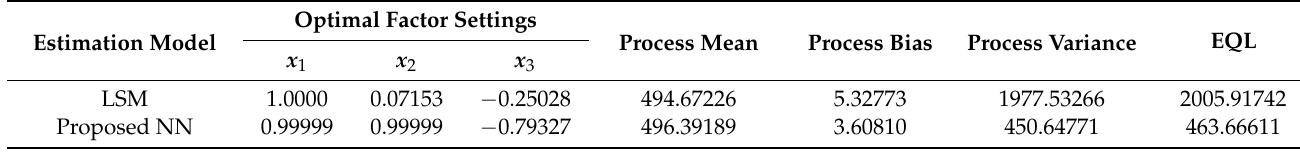
Table 5. Comparative analysis results.